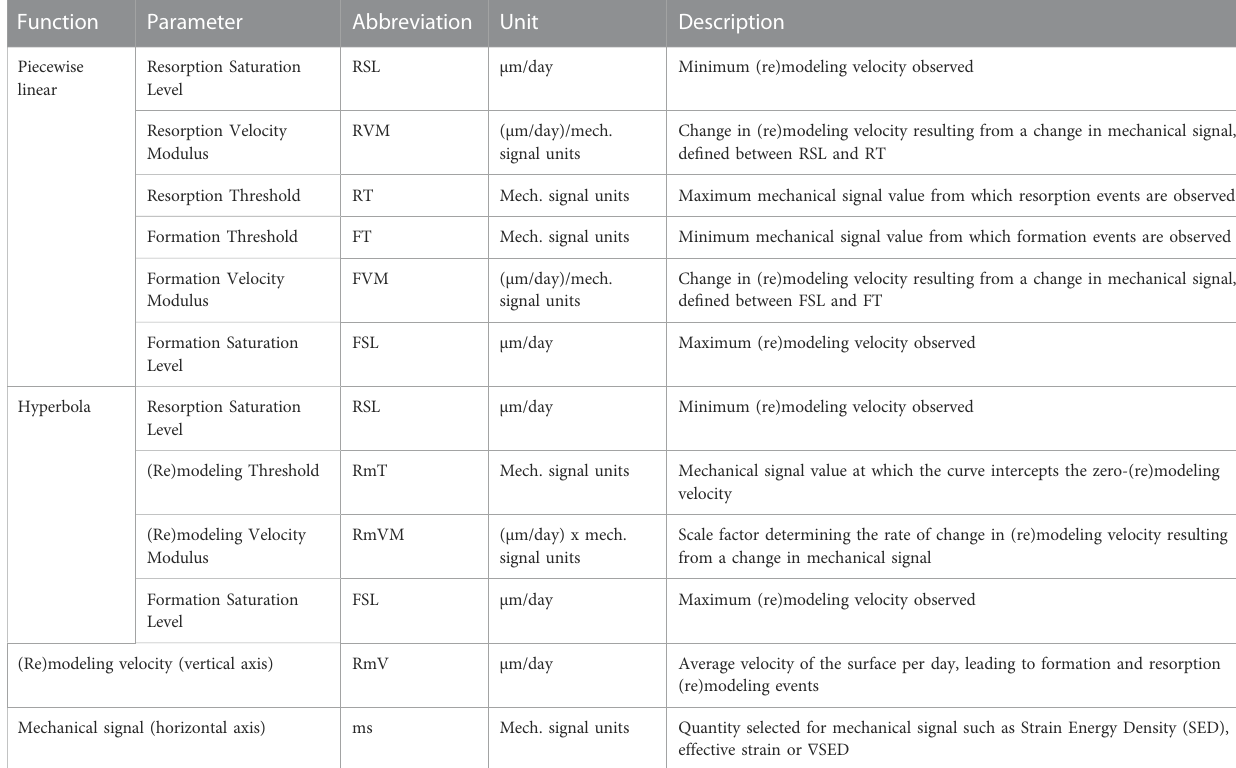
TABLE 1 Mechanostat parameters derived from the piecewise linear and hyperbola functions fi tted to the (re)modeling velocity curves.